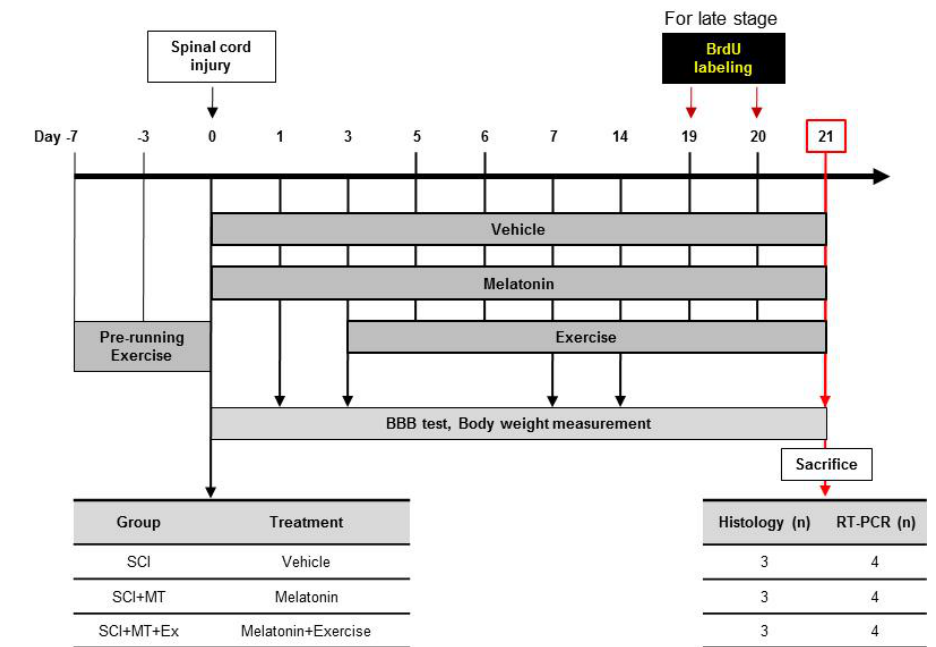
Figure 5. Schematic representation of experimental